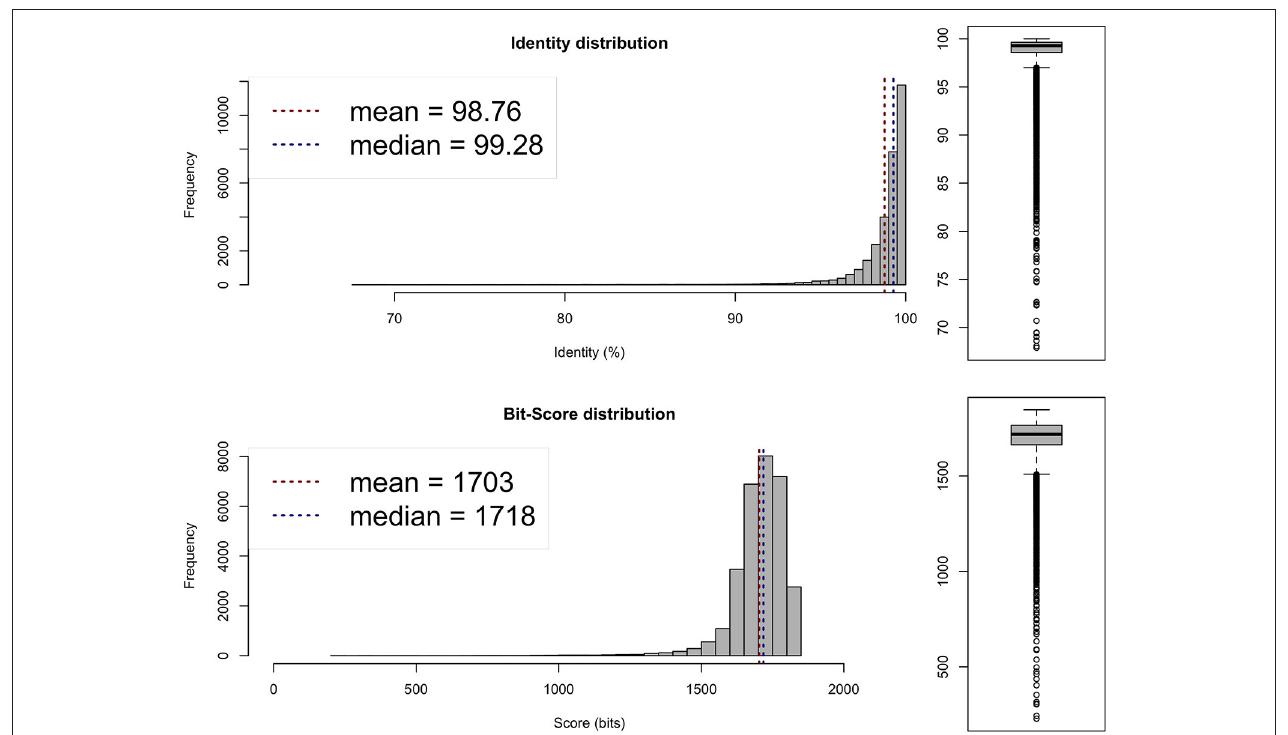
FIGURE 2 | Average Nucleotide Identity (ANI) plot between R. sullae IS123 T and R.sullae WSM1592.